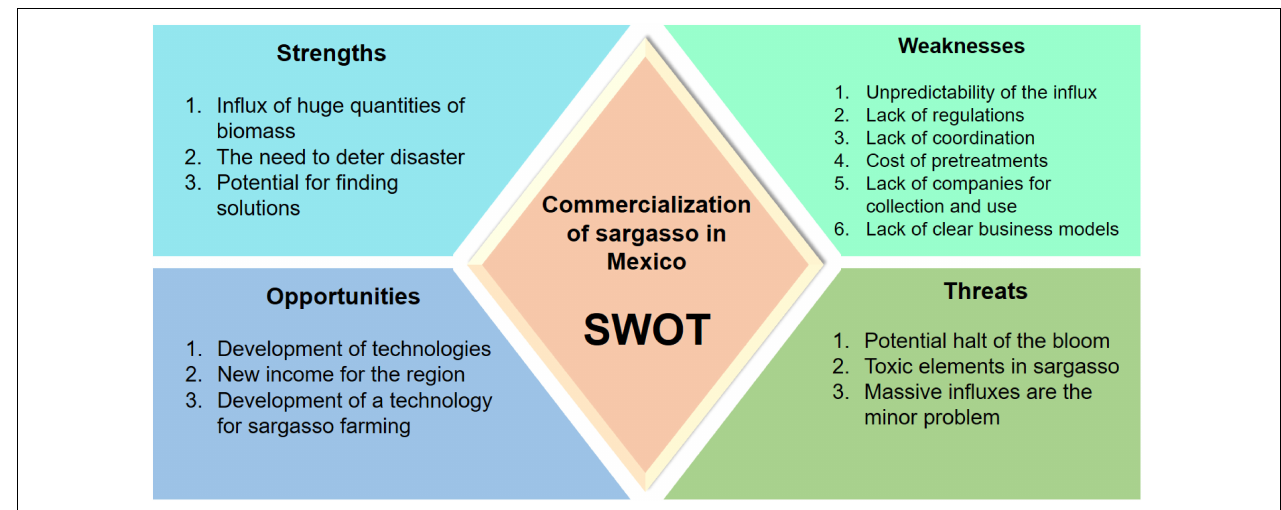
FIGURE 10 | Analysis of strengths, weaknesses, opportunities, and threats (SWOT) related to the commercialization of sargasso in Mexico.